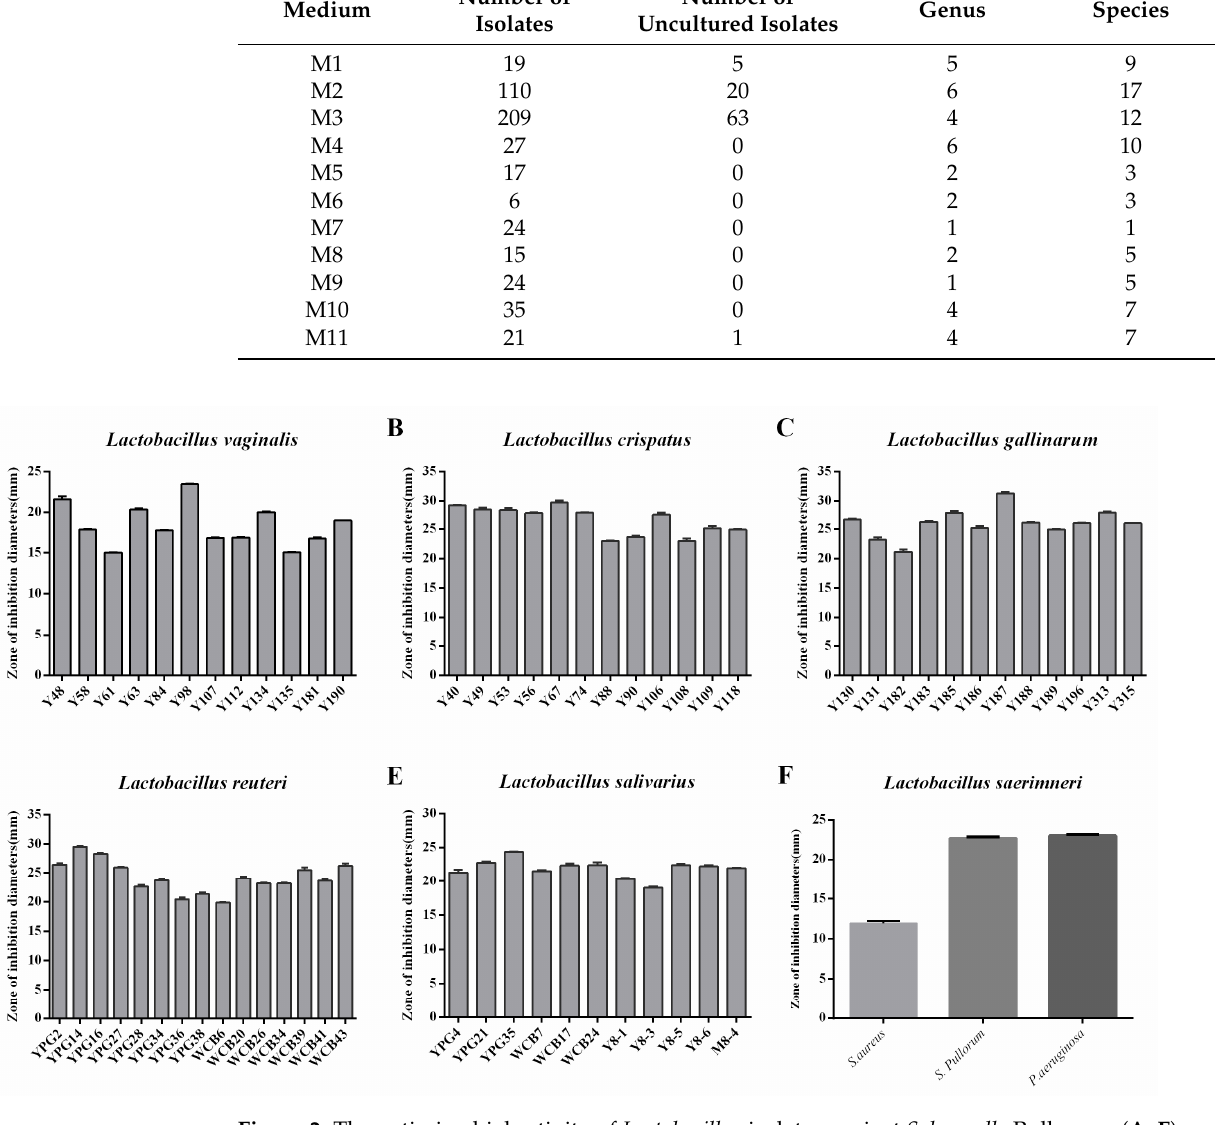
Figure 2. The antimicrobial activity of Lactobacillus isolates against Salmonella Pullorum. ( A – F ) represent the antimicrobial activity of L. vaginalis , L. crispatus , L. gallinarum , L. reuteri , L. salivarius , and L. saerimneri , respectively.